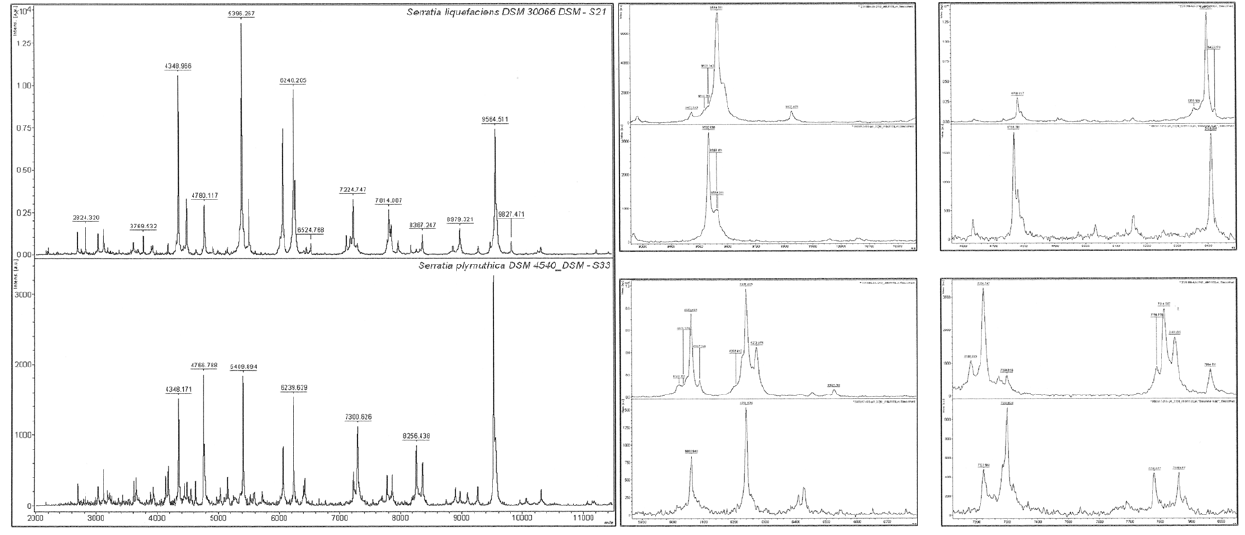
Figure 3. MALDI-TOF mass spectra of two Serratia species. 16S rRNA sequencing indicated that isolates S21 and S33 were both Serratia plymuthica . However there are differences in their mass-spectral patterns. The whole m/z 2,000–20,000 spectra of the two isolates are shown in the main panel (left). The small panels show highlighted regions of the spectra with more significant the mass-to-charge ratio ( m/z ) differences.